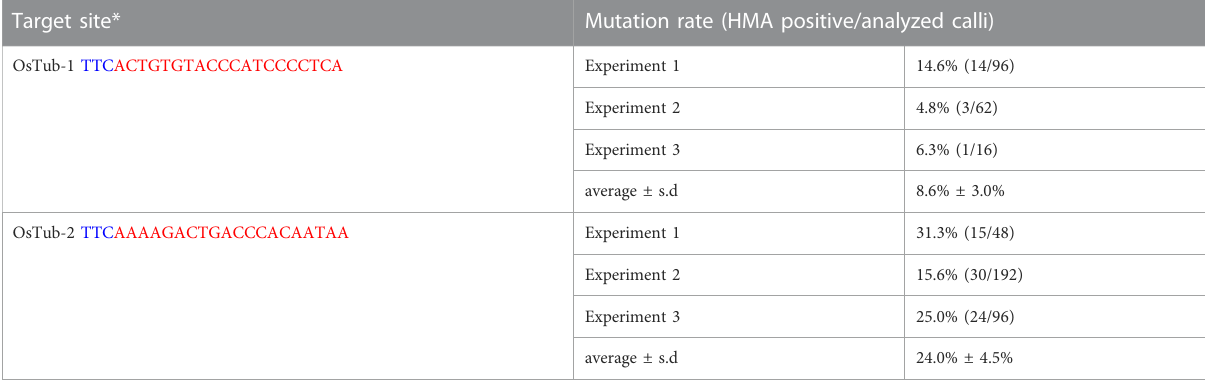
TABLE 1 Summary of HMA in SpCas12-transformed calli. Target